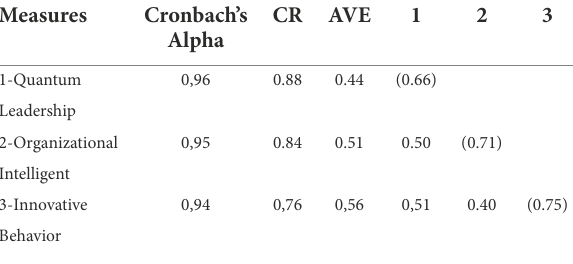
TABLE 3 Cronbach’s Alpha, AVE and CR values for each measures and